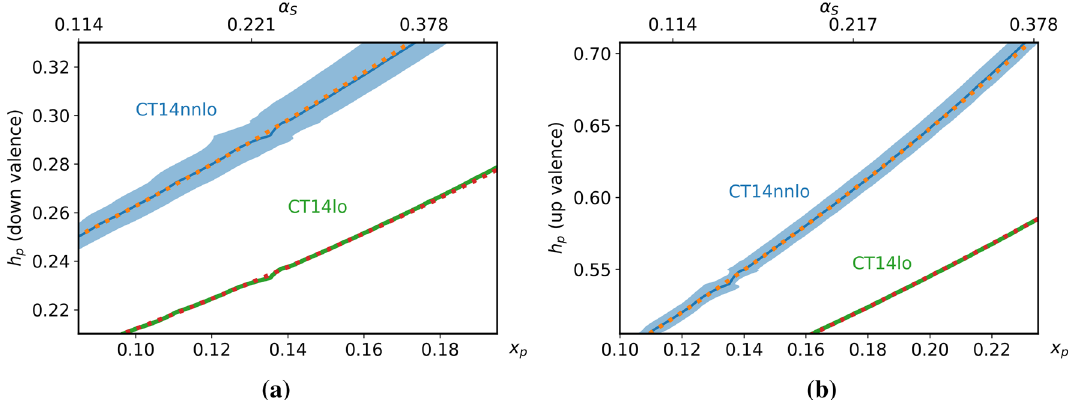
Fig. 4 The x dependence of xq V ( x , Q 2 ) function for d - and u -valence quarks, calculated for CT14nnlo [38] PDFs at various Q 2